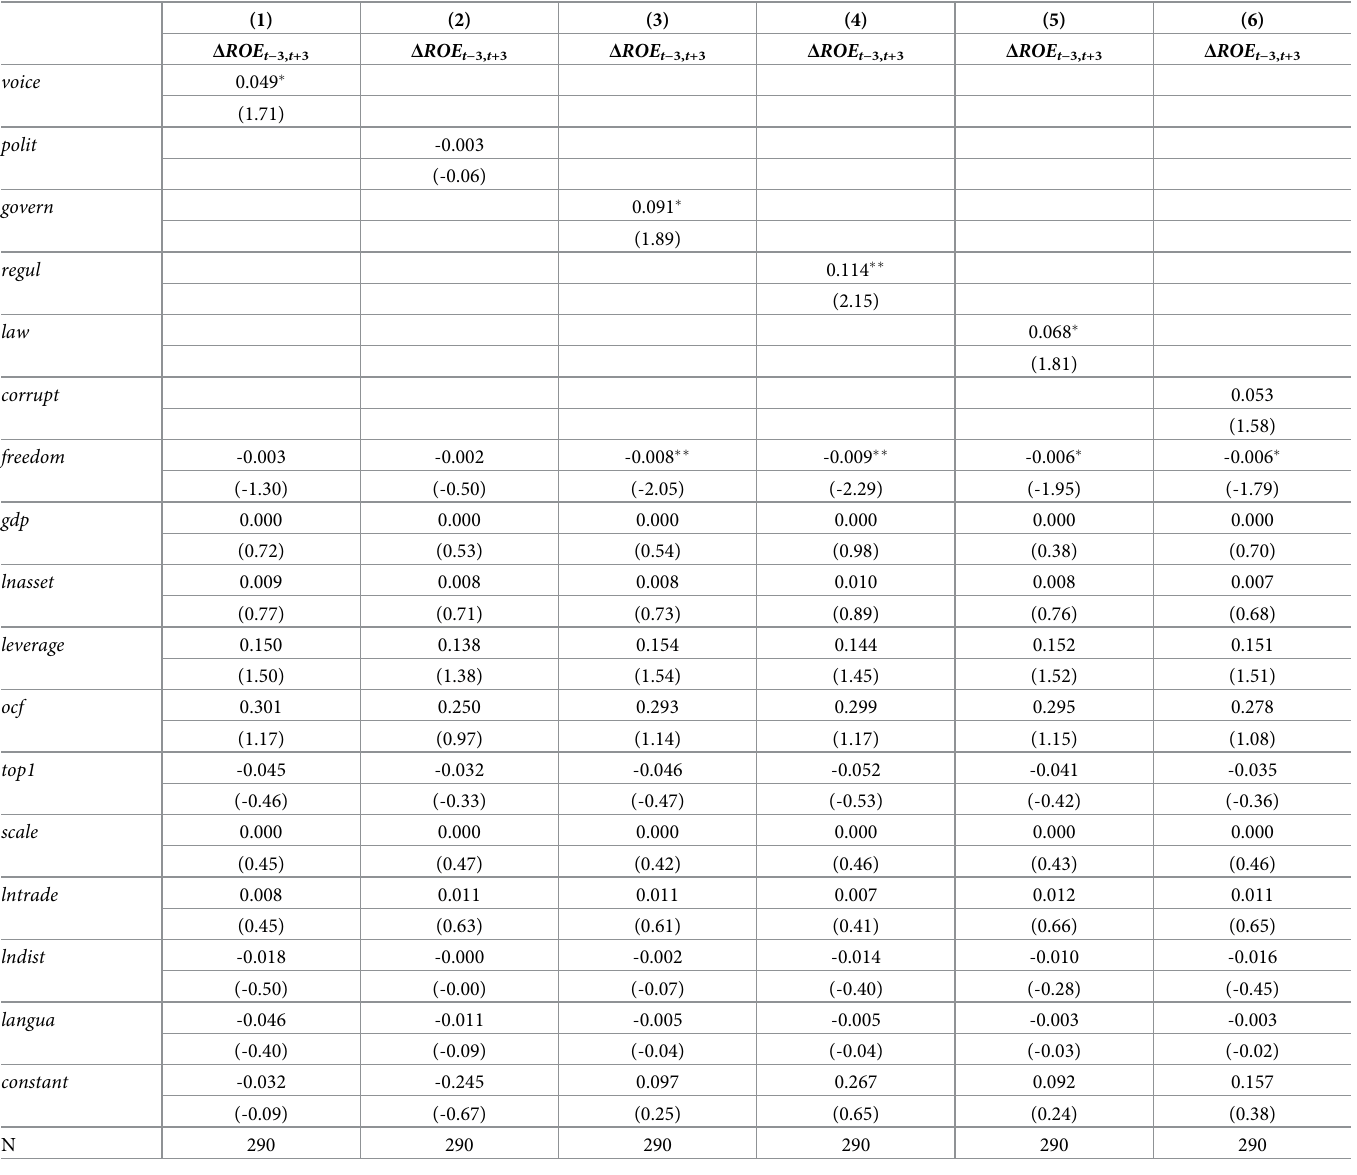
Table 6. Robustness test of six dimensions of governance capacity and long-term M&A